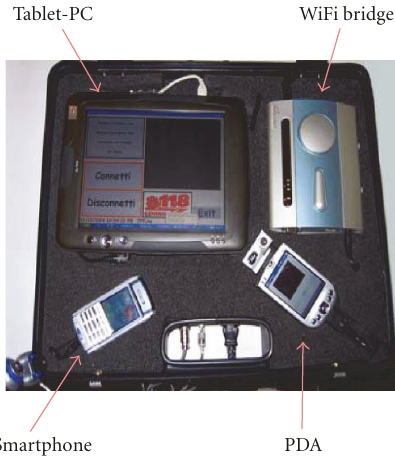
Figure 4: Portable unit